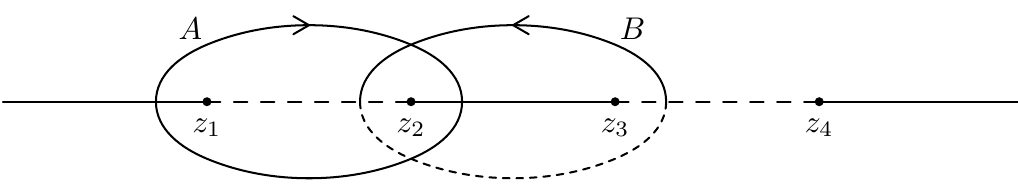
Figure 2 . A and B cycles for a complex plane with 4 twist (cid:12)elds